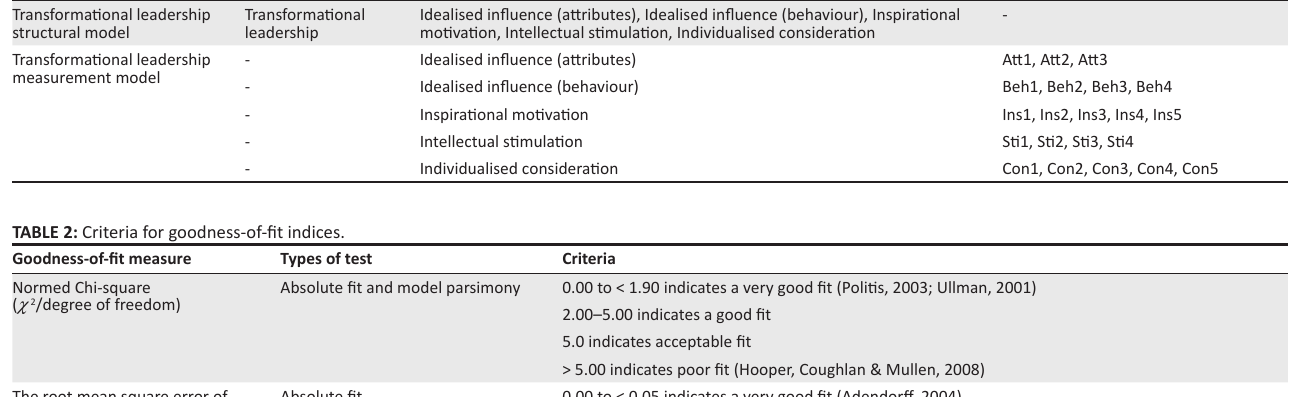
TABLE 1: Definition of structural constructs and measurements for the transformational leadership model and its sub-constructs. Model